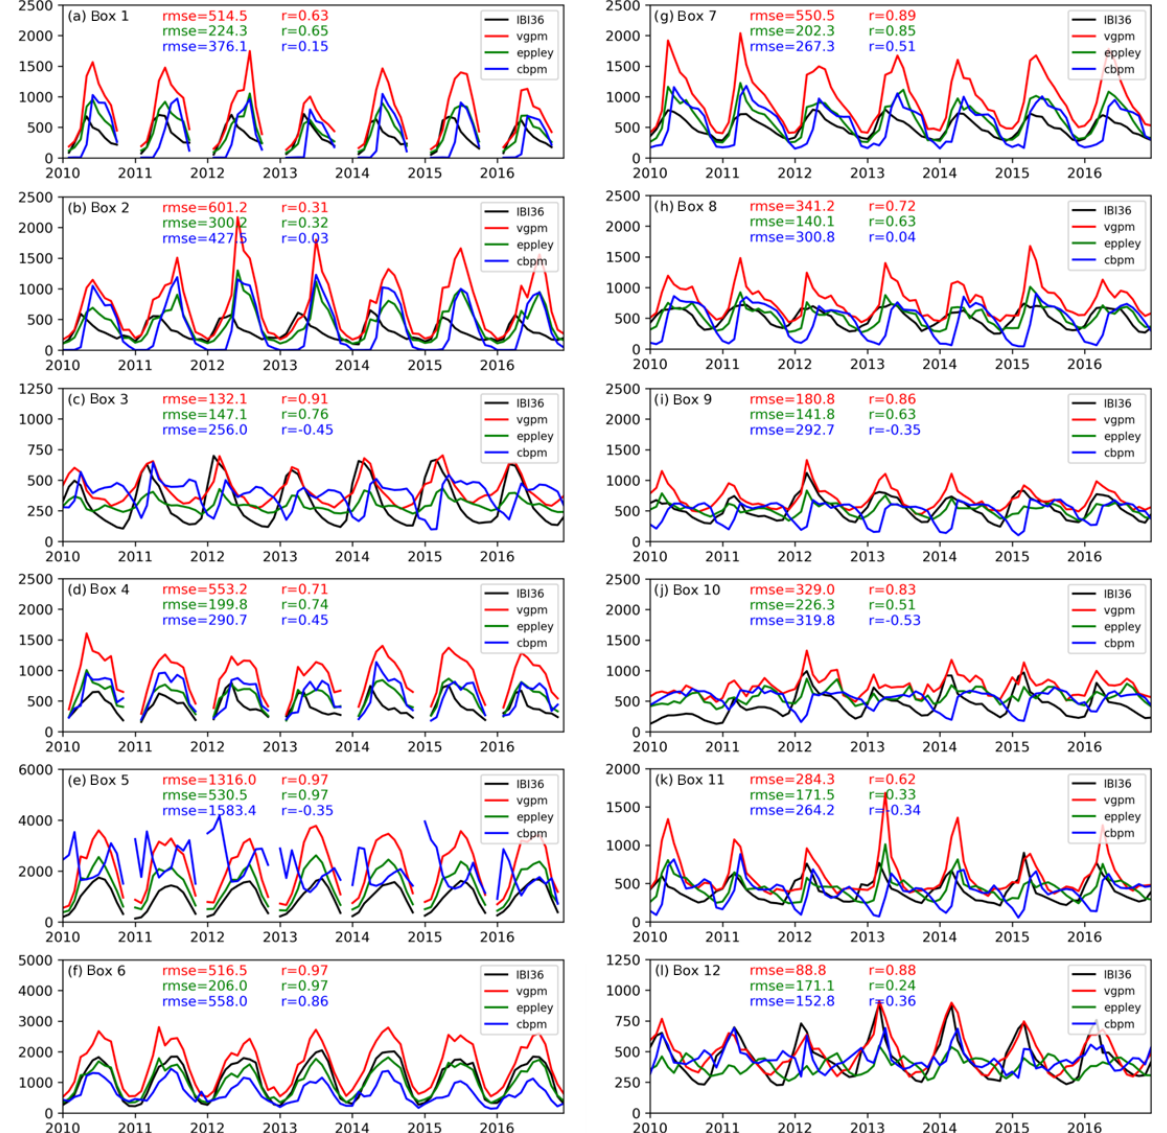
Figure 6. Time series of depth-integrated NPP (mgCm − 2 d − 1 ) between 2010 and 2016. IBI36 is in black, VGPM in red, Eppley-VGPM in green and CbPM in blue. NPP is averaged over 12 small boxes defined in Fig. 1. Note the different scales on the y axis. The RMSE p (cid:104) ( model − obs ) 2 (cid:105) ) and correlation ( r ) between the model and the NPP products (using corresponding colours) are indicated for each time (